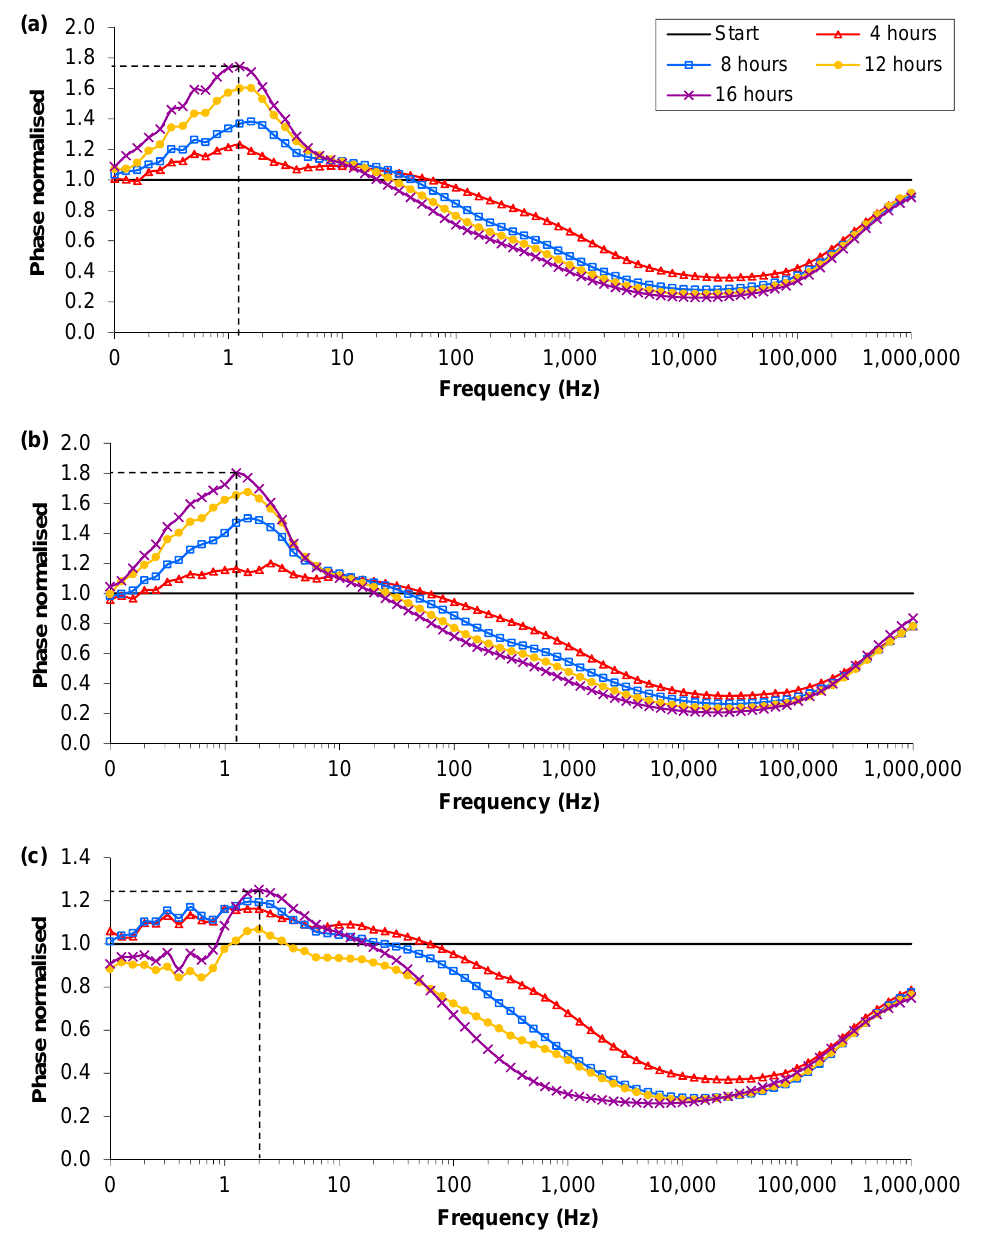
Figure 5. An example of the normalised profiles with Ag-AgCl sensors in parallel suspensions: ( a ) MHB; ( b ) MHB and low density RN4220 at 16 h; ( c ) MHB and high density RN4220 at 16 h. Dotted lines indicates the normalised phase angle peak at 16